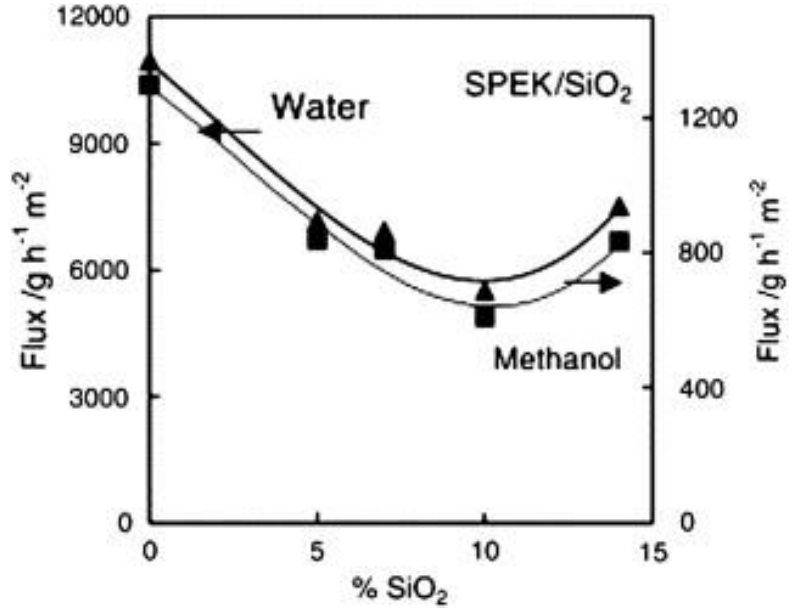
Figure 5. Methanol–H 2 O flux in pervaporation experiments at 55 °C by modification of an SPEK membrane with hydrolyzed TEOS. Reprinted with permission from [72]. Copyright (2002) Elsevier Science B.V.